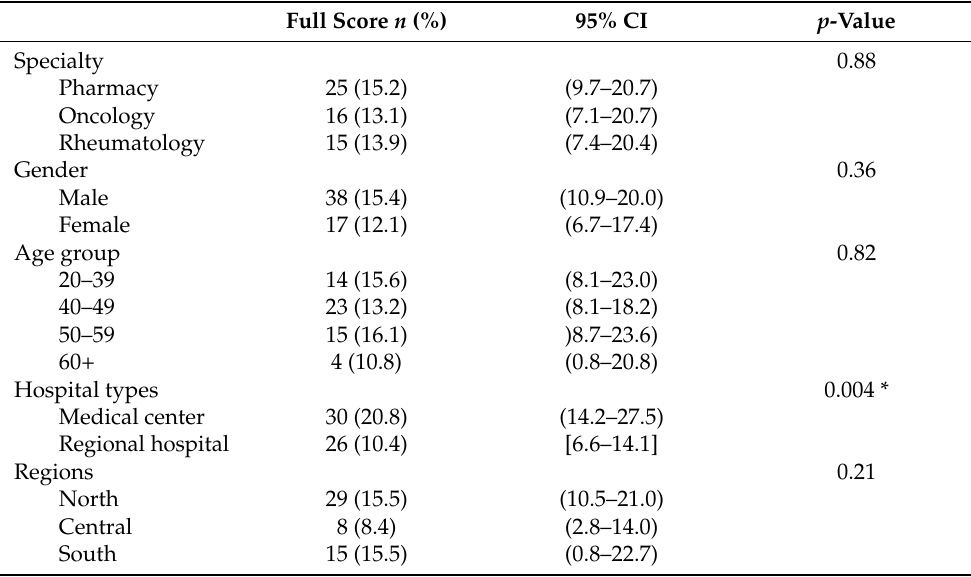
Table 2. The association between respondents’ knowledge and the five demographic